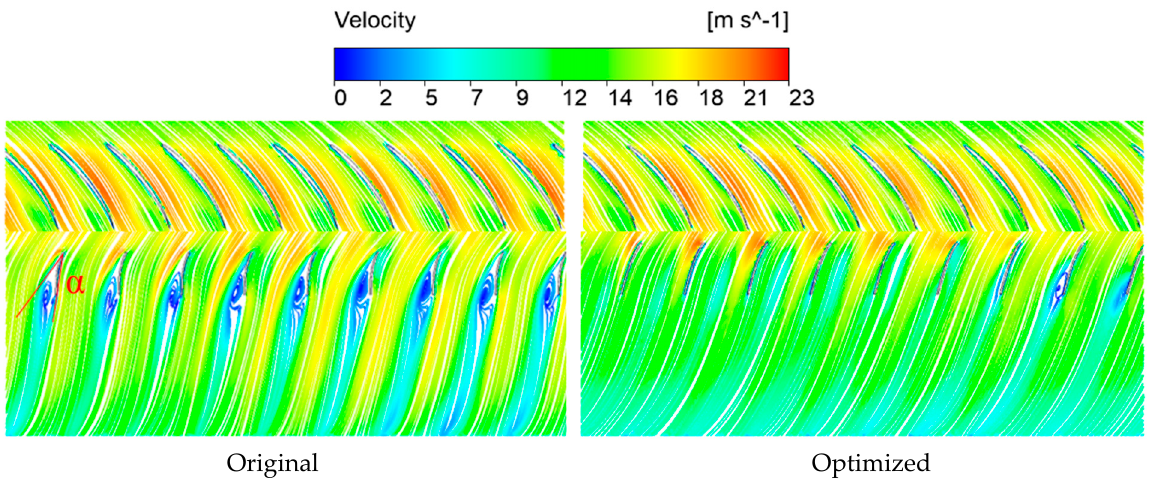
Figure 21. The streamline distribution at 0.5 blade height before and after optimization.